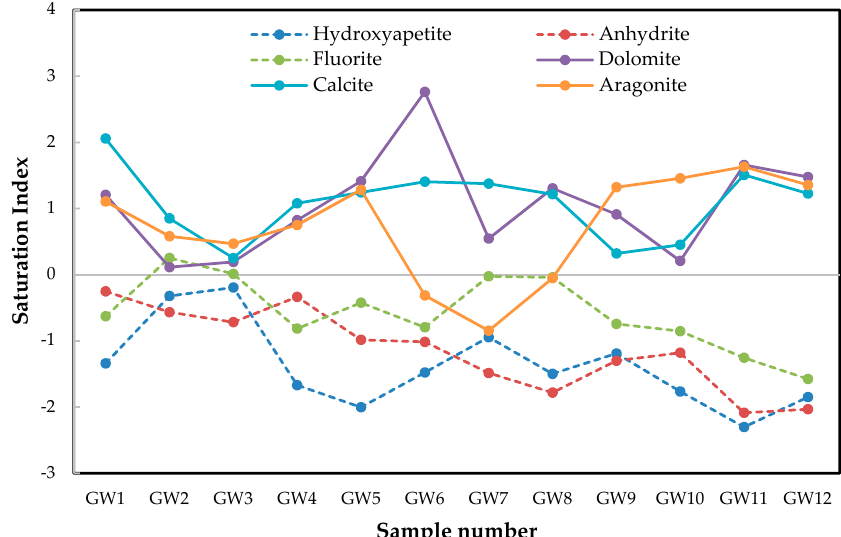
Figure 8. Saturation index for selected minerals related to fluoride in groundwater.